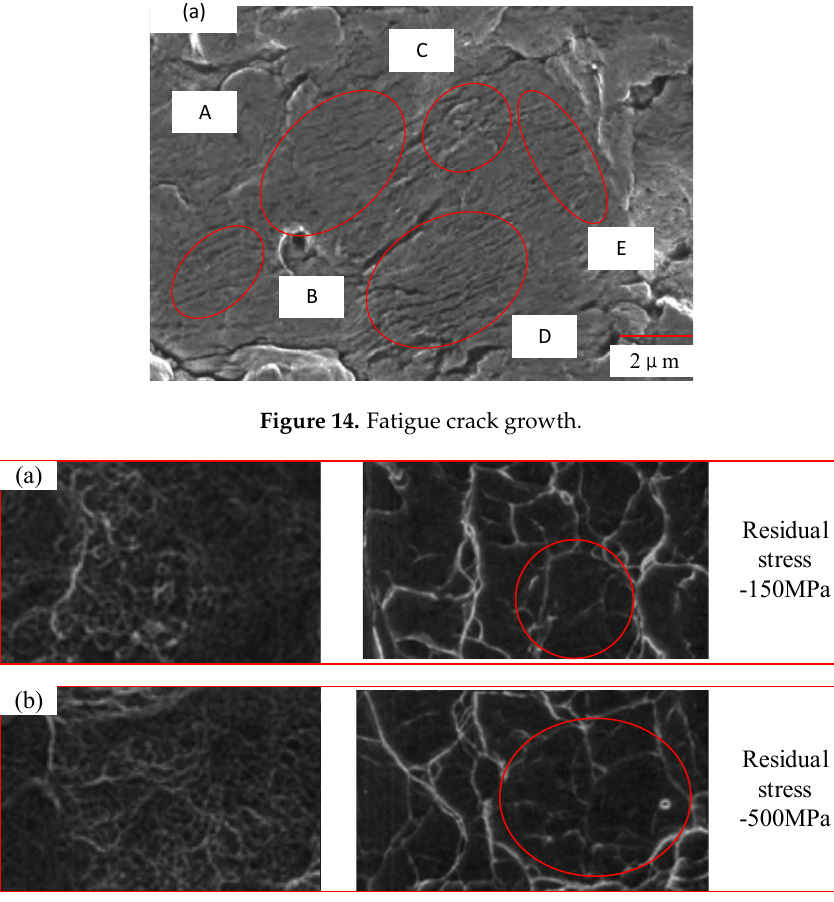
Figure 15. SEM fracture morphology: ( a ) under the residual stress of − 150 MPa; ( b ) under the residual stress of − 500 MPa.